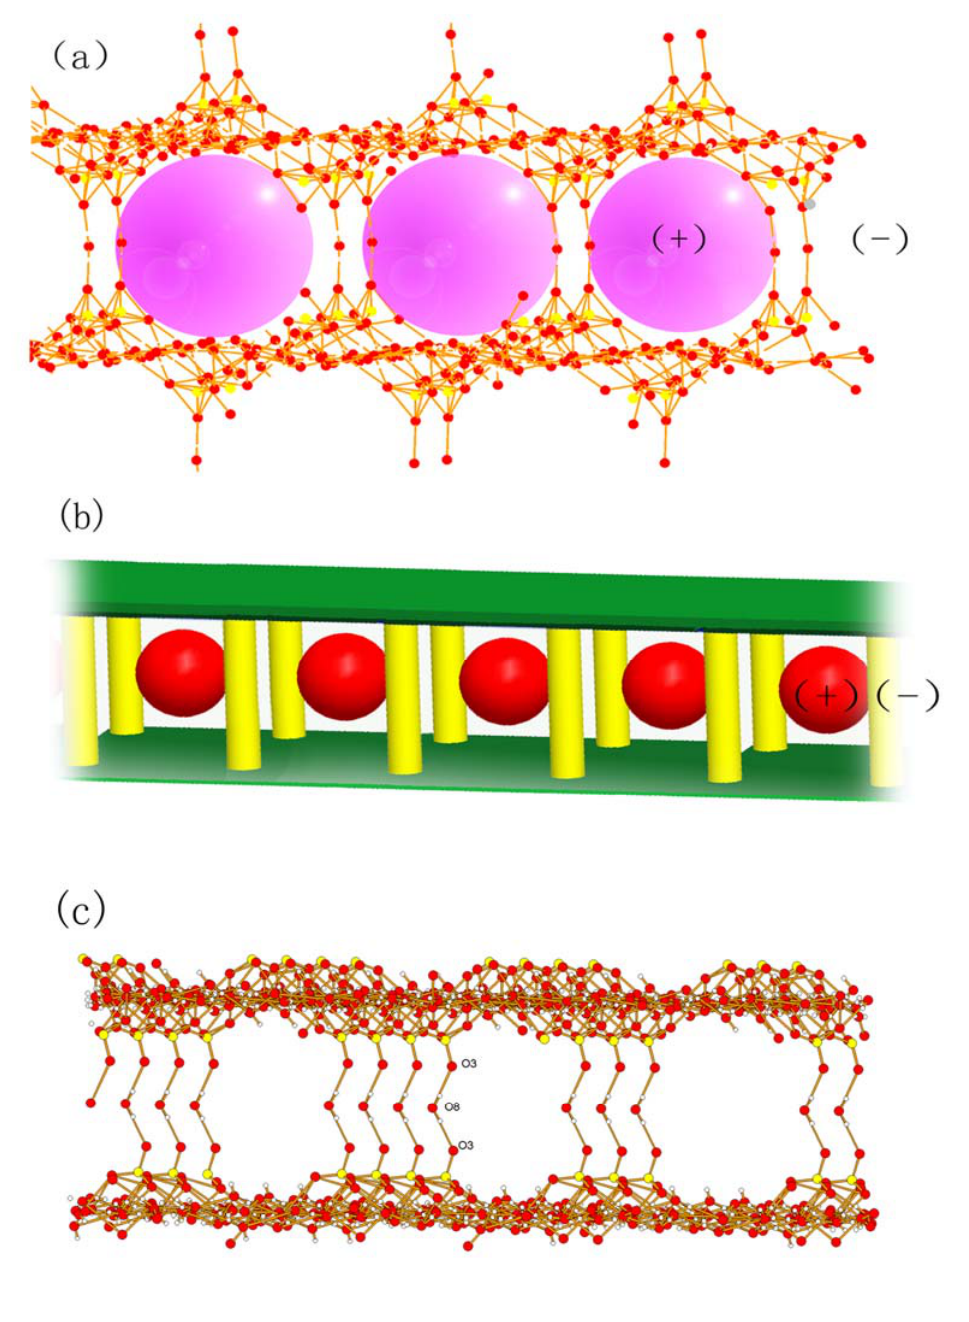
Figure 3. Model of the 3D structure showing the frameworks formed by the guest molecules (pillar-layer structure) with negative charge and the host (red ball) with positive